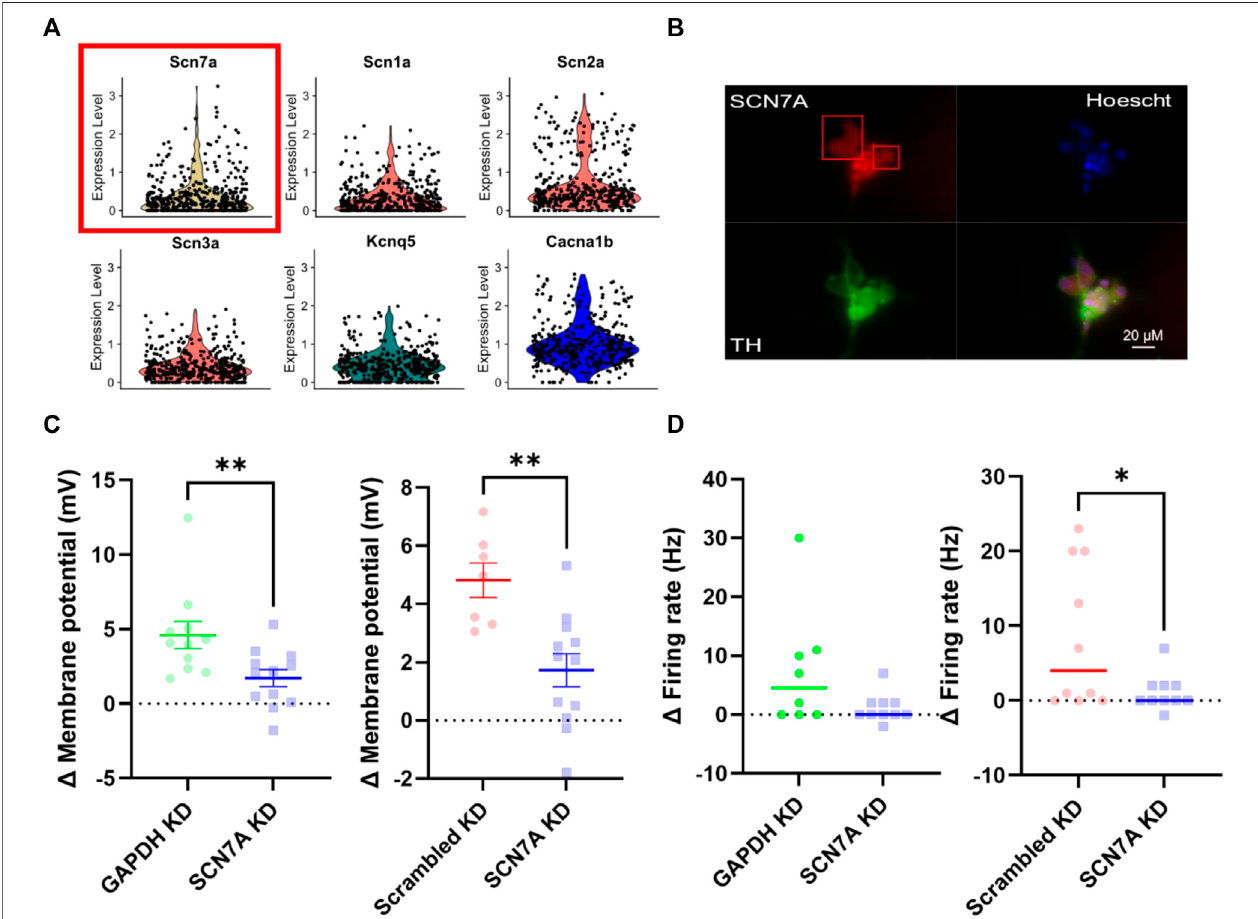
FIGURE 5 | Na x is responsible for sodium sensitivity in stellate ganglia neurons. (A) Single-cell RNA-sequencing highlighted expression of the Na x encoding gene SCN7A (Yellow, with red box) at a transcript level in the stellate ganglia sympathetic neurons. These data are shown against expression of other ion channel encoding genes, SCN1A - SCN3A (Na v ) (Red), KCNQ5 (K v ) (Green) and CACNA1B (Ca v ) (Blue). Here expression level indicates normalized count data. Here thecount dataper cell is divided by the total number of counts within that cell, multiplied by a scale factor and then natural-log transformed. (B) Immunohistochemistry highlights protein expression ofNa x intyrosinehydroxylase positivestellate ganglia neurons. Cultured stellate ganglia cells wereco-labelled for Na x (Red), thesympathetic neuron marker, tyrosine hydroxylase (Green), and the nuclear stain Hoescht 33342 (Blue). (C) Knockdown of SCN7A signi fi cantly reduced the depolarization induced by an additional 30 mM NaCl, compared to GAPDH RNA knockdown (-2.87 ± 1.04 mV; n = 11 – 12; One-tailed unpaired t -test; p = 0.006) knockdown of a scrambled RNA control ( – 3.091 ± 0.8674 mV; n = 7 – 12; One-tailed unpaired t -test; p = 0.0012). (D) Knockdown of SCN7A caused a non-signi fi cant decrease in the increase in fi ring rate following170 mM[NaCl] o (4.5 – 0 Hz;n=8 – 10;One-tailedMannWhitneytest; p =0.06).Similarly, SCN7A knockdownreducedthe fi ringrateinducedby170 mM[NaCl] o when compared to a scrambled RNA knockdown control (4 Hz – 0 Hz; n = 10; One-tailed Mann-Whitney test; p =